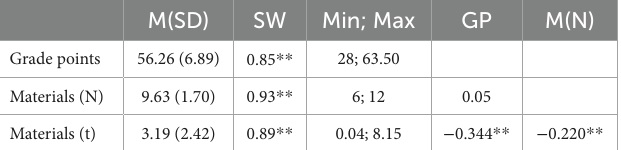
TABLE 3 Descriptive statistics and correlations – ICT